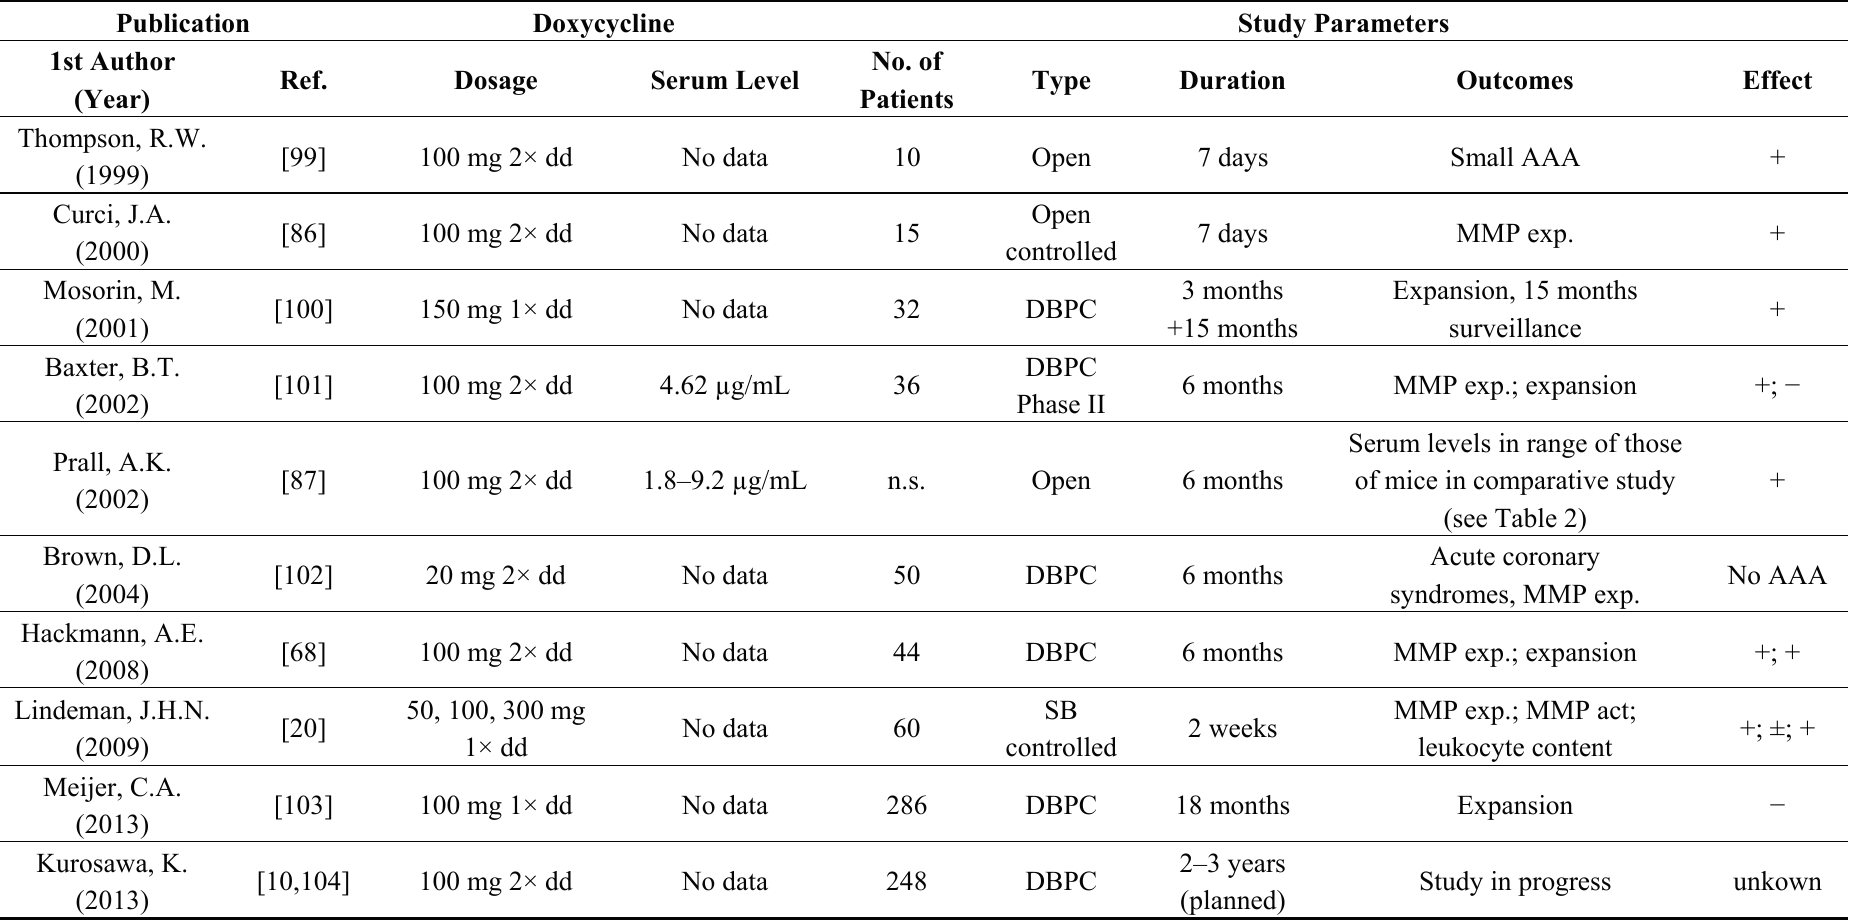
Table 3. Effect of doxycycline in clinical trials with AAA